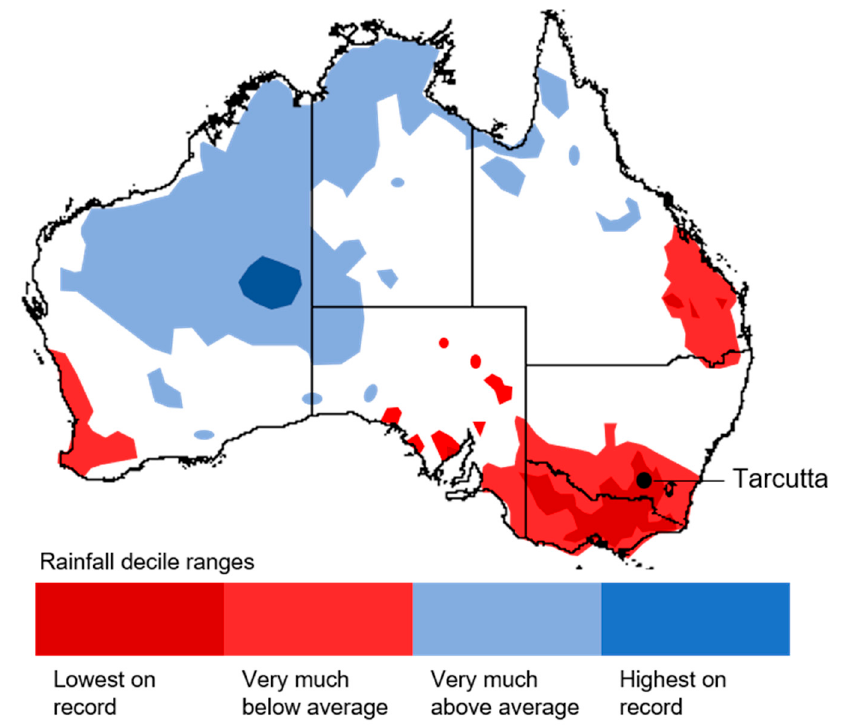
Figure 2. Map: Rainfall amounts based on rainfall deciles from 1997 to 2009 recorded by the Australian Bureau of Meteor- ology, see [19] for details. The case study site, Tarcutta, is